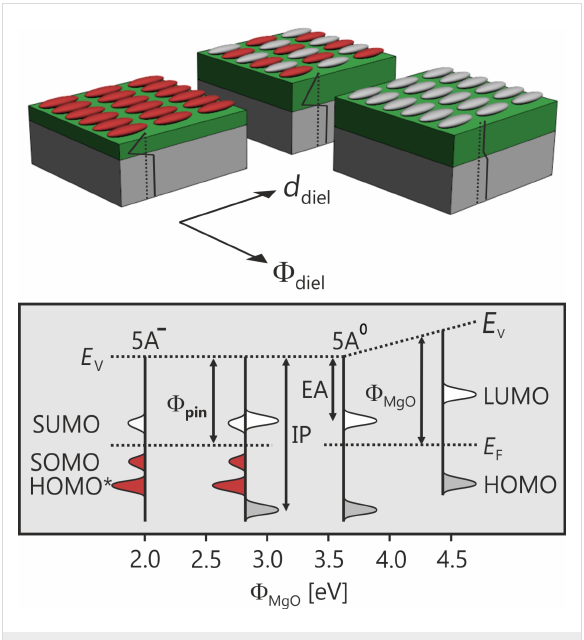
Figure 1: Molecular level schematic of integer charge transfer across dielectric films. Top: The ratio of integer charged (red) and neutral (gray) molecules is determined by the work function of the substrate after dielectric film growth ( Φ diel ) and the dielectric film thickness ( d diel ), according to the capacitor model. Bottom: Energy level alignment for charged 5A − and neutral 5A 0 on MgO(100)/Ag(100) from the Fermi level pinning to the vacuum level alignment regime. HOMO* refers to orbitals of charged